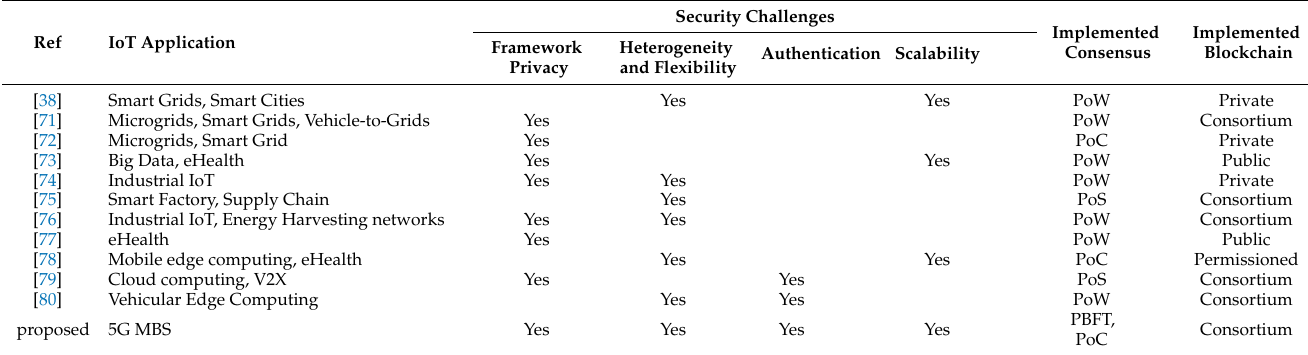
Table 4. Security challenge comparison of blockchain applications in IoT